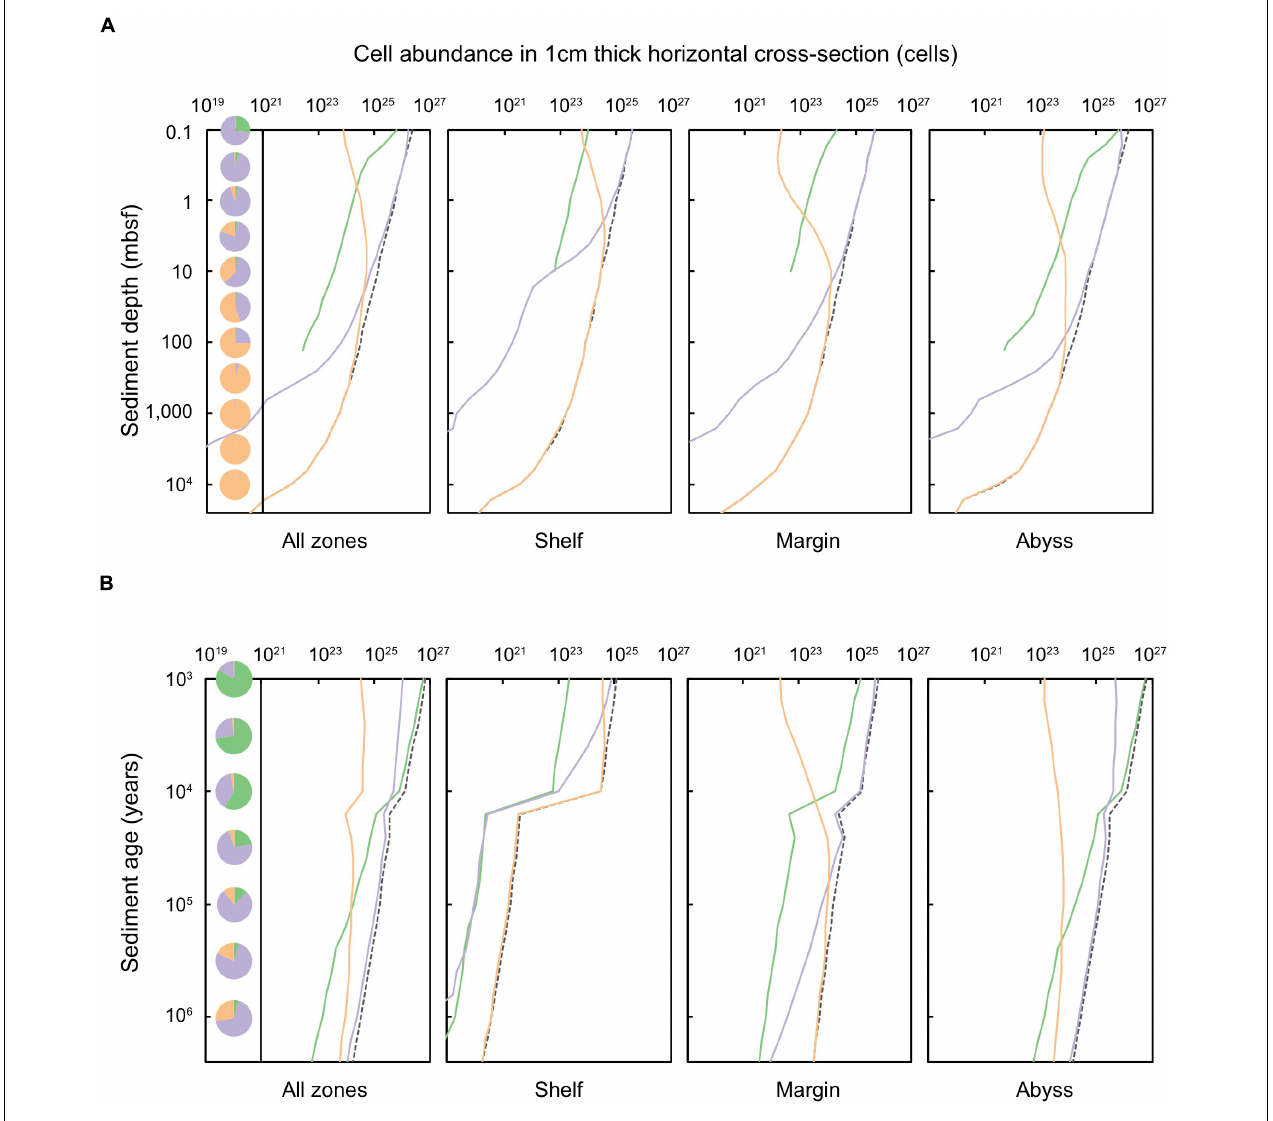
FIGURE 3 | Total cells in a 1 cm thick layer of marine sediments deposited up to 2.59 million years ago, according to equal (A) sediment depth (shown for sediments at 0.1 to ∼ 10,000 mbsf) and (B) sediment age (1,000 years to 2.59 million years) for shelf, margin, abyss, and total global sediments. The dashed black line represents the total cells at specific depth or age layers. Solid lines indicate the cell abundance in specific sediment catabolic zones in which cells are situated: green represents oxic sediments, lilac denotes sulfate-reducing sediments, and orange signifies methanogenic sediments. Pie charts indicate the proportion of cells of that layer that are stored within oxic, sulfate-reducing, and methanogenic